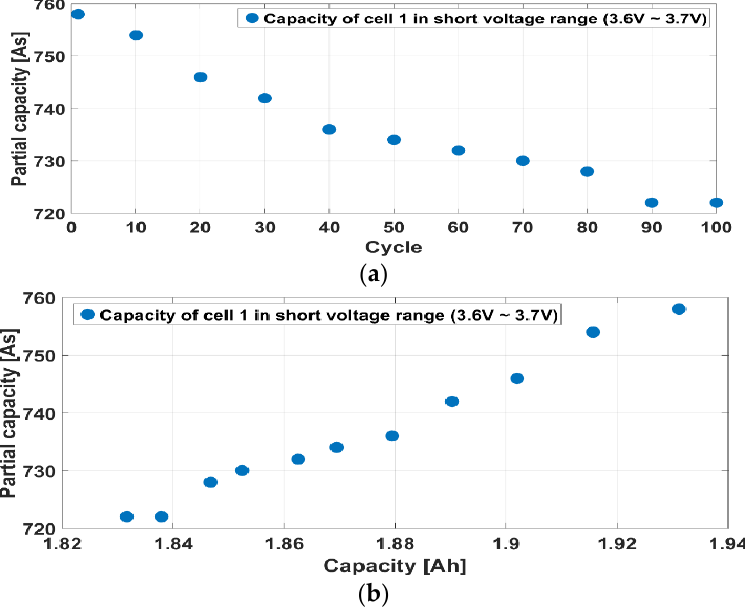
Figure 12. Variation in partial capacity with respect to the cycle and discharge capacity in the short voltage range (3.6–3.7 V) according to the aging cycle test on the no. 1 cell: ( a ) cycle and ( b ) discharge capacity.